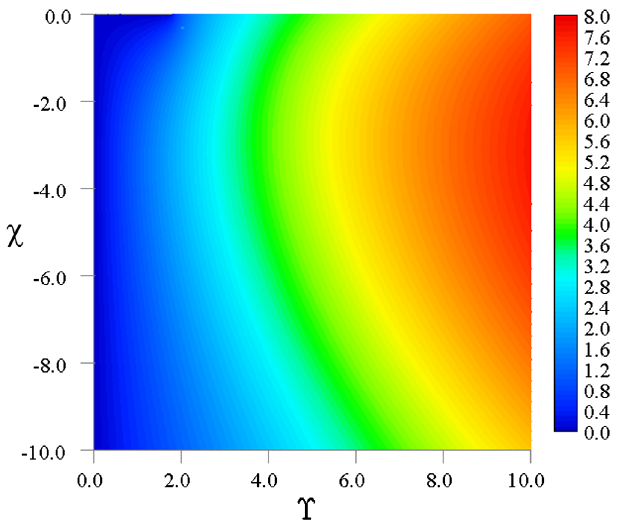
FIG. 16. The flat contour plot of the growth factor g × T the most unstable mode) as a function of ϒ and negative χ at the rms bunch length of 2 cm in the trapezoidal wake model for the Vlasov analysis with the Gaussian bunch distribution.